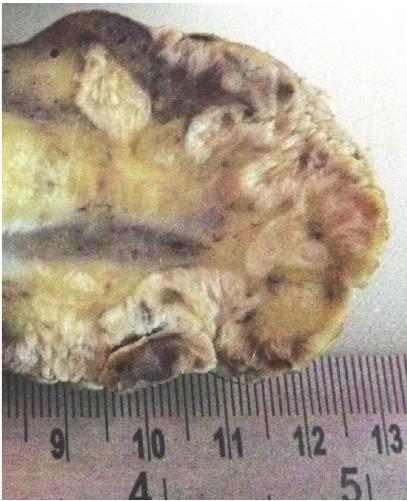
Figure 1: Close-up view of total penectomy specimen showing papillomatous growth.